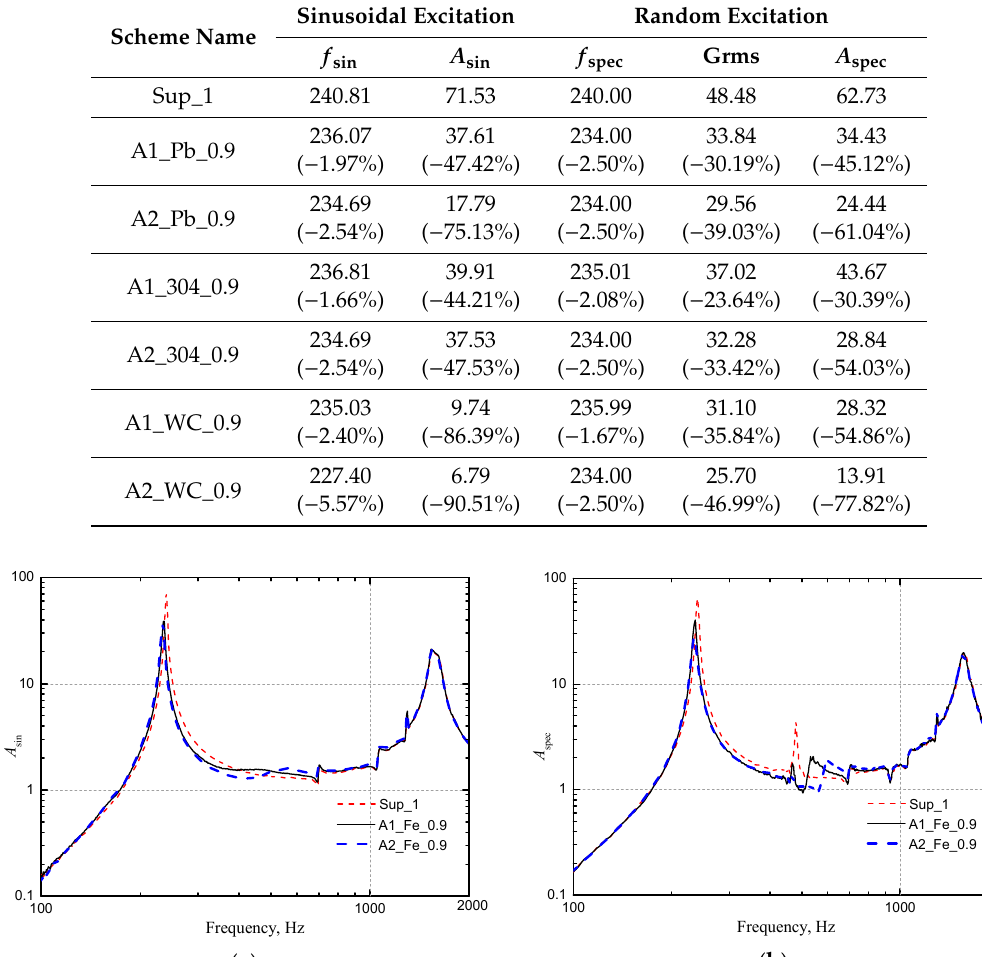
Table 8. Optimal cavity analysis.